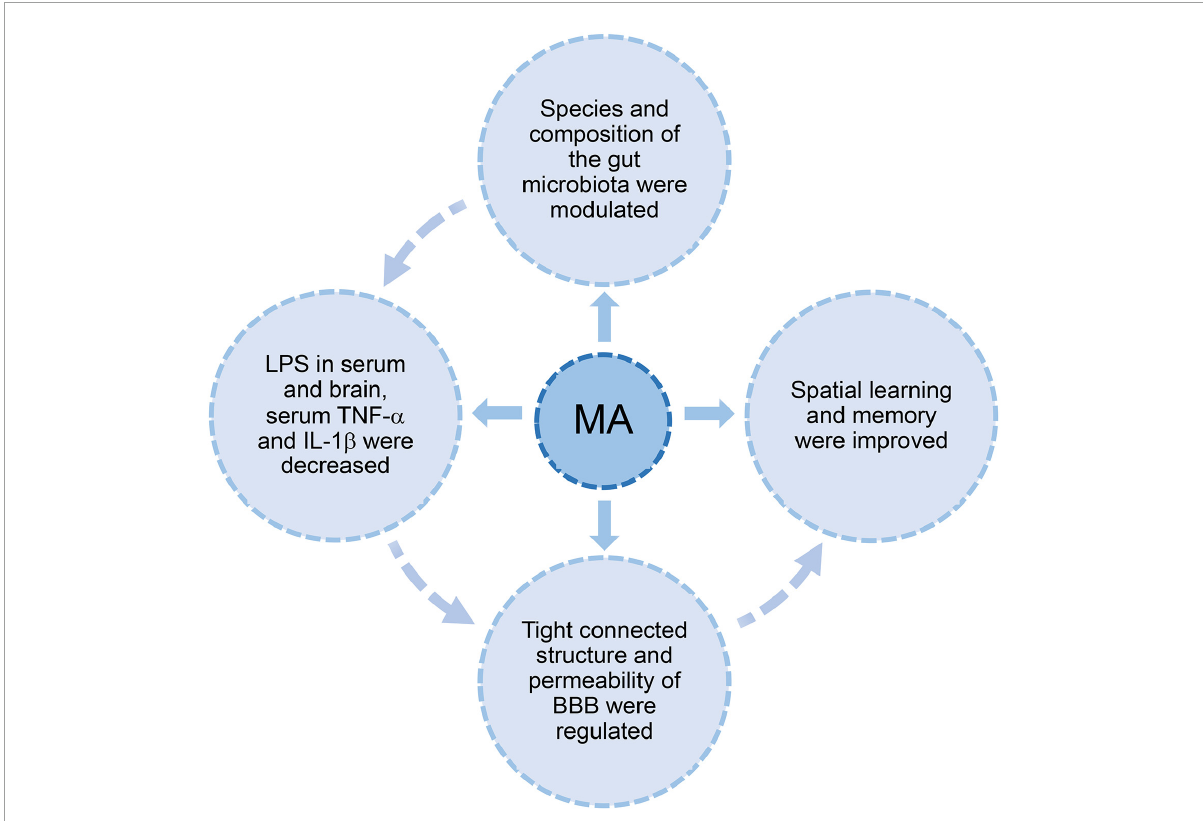
FIGURE6 The hypothesis diagram about the relationship between acupuncture, gut microbiota, and BBB. Acupuncture modulated the diversity and species composition of gut microbiota. Intestinal LPS leakage diminished with the decrease in proinflammatory bacteria. This process may improve BBB dysfunction, which was evidenced by an increase in tight junction proteins and lower permeability. Cognitive ability improved with the recovery of BBB dysfunction. One possible mechanism of acupuncture regulation of BBB dysfunction via the gut microbiome is the reduction of LPS, TNF- α , and IL-1 β